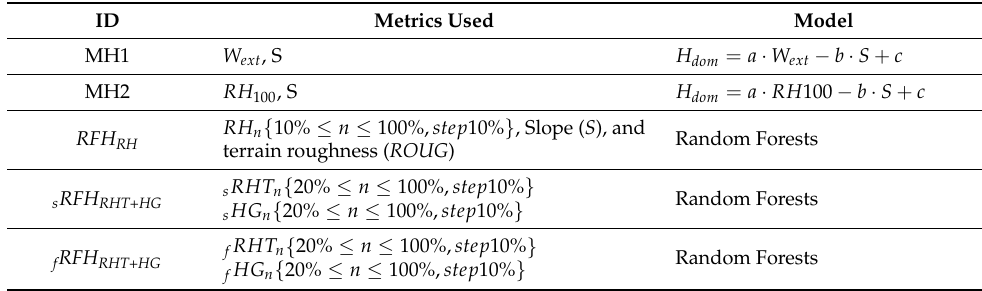
Table 2. List of the models used for the estimation of H dom